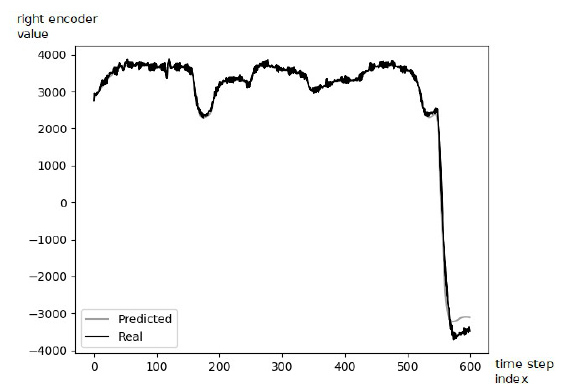
Fig. 6. An example of the right encoder readings – forecasted (grey) and real (black) values applying the stacked LSTM model.